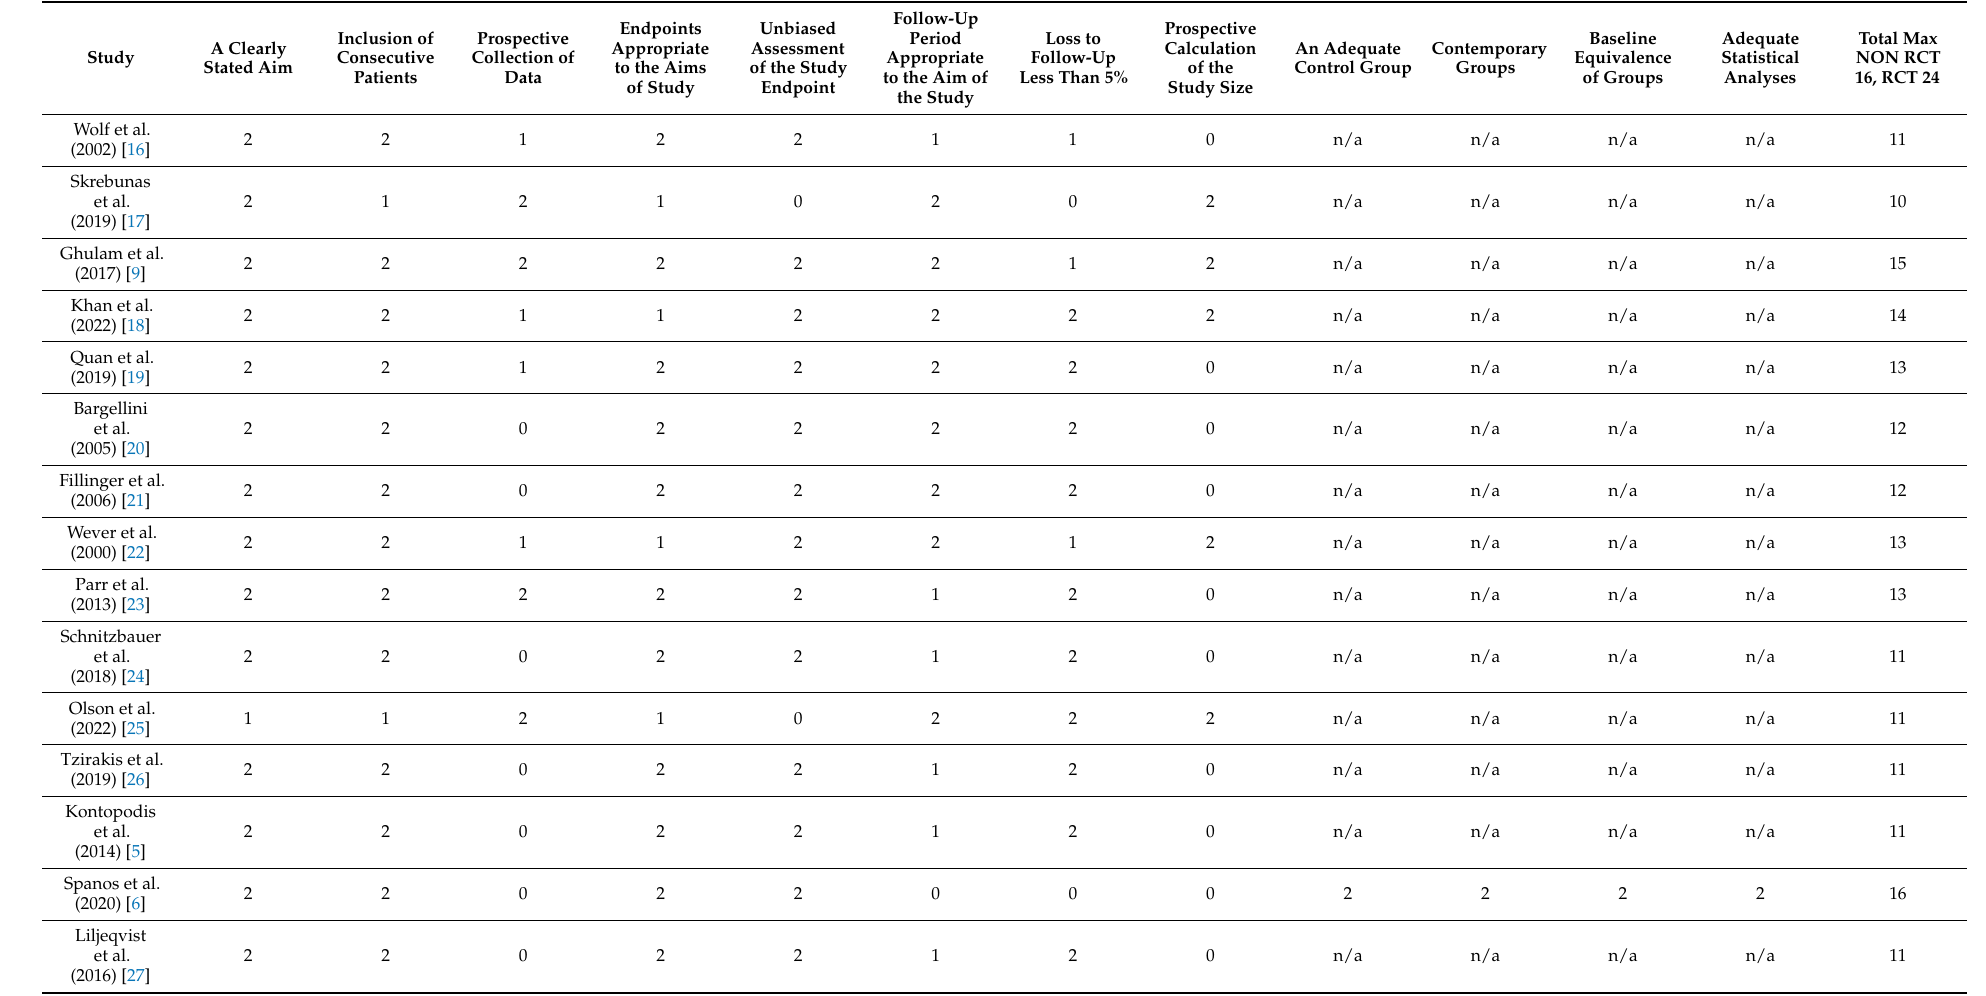
Table 2. Quality assessment according to MINORS